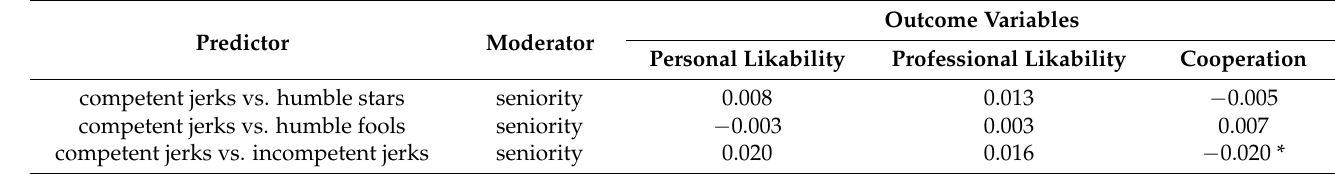
Table 4. The Regression Coefficients of the Interaction